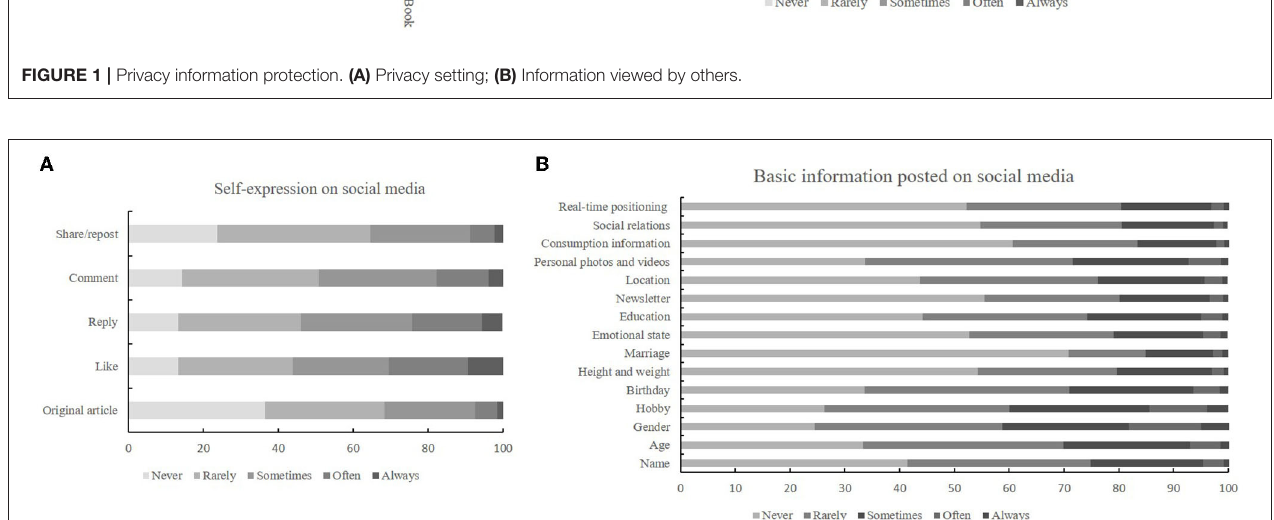
FIGURE 2 | Individual self-presentation on social media. (A) Expression willingness; (B) Basic information posted on social media.